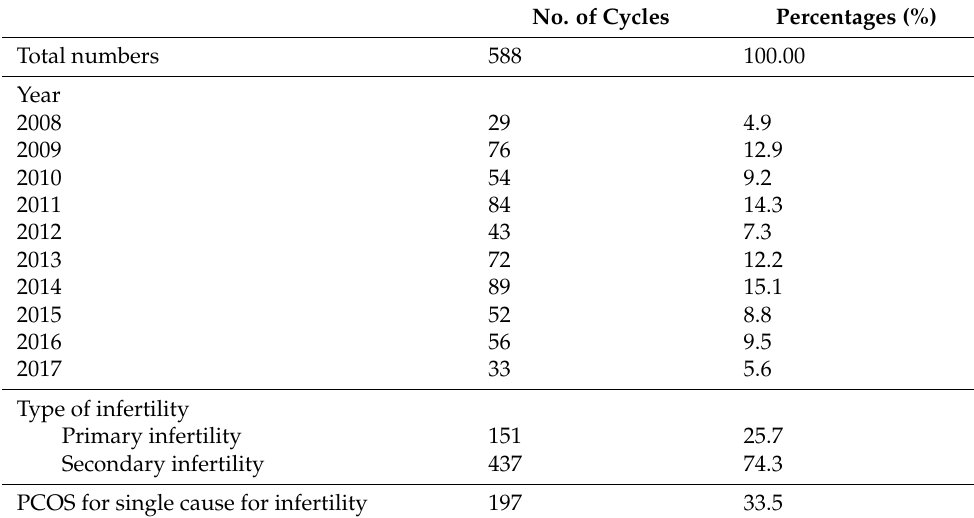
Table 1. General information of